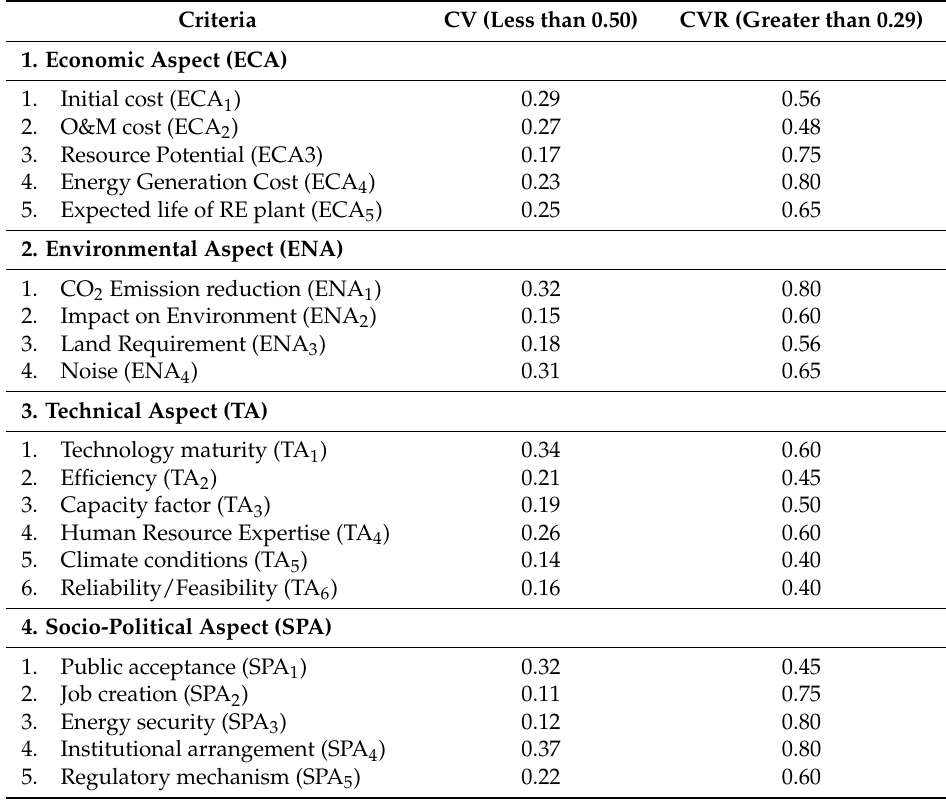
Table A2. Coefficient of variation (CV) and content validity ratio (CVR) results of final evaluation criteria.